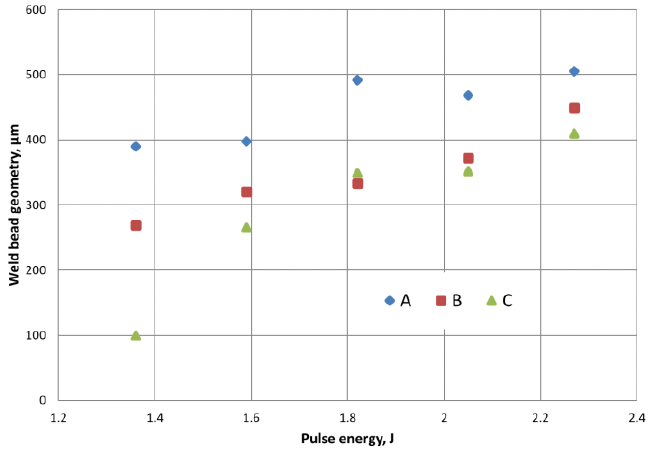
Figure 4. View of obtained welds for lap joints in cross-section.